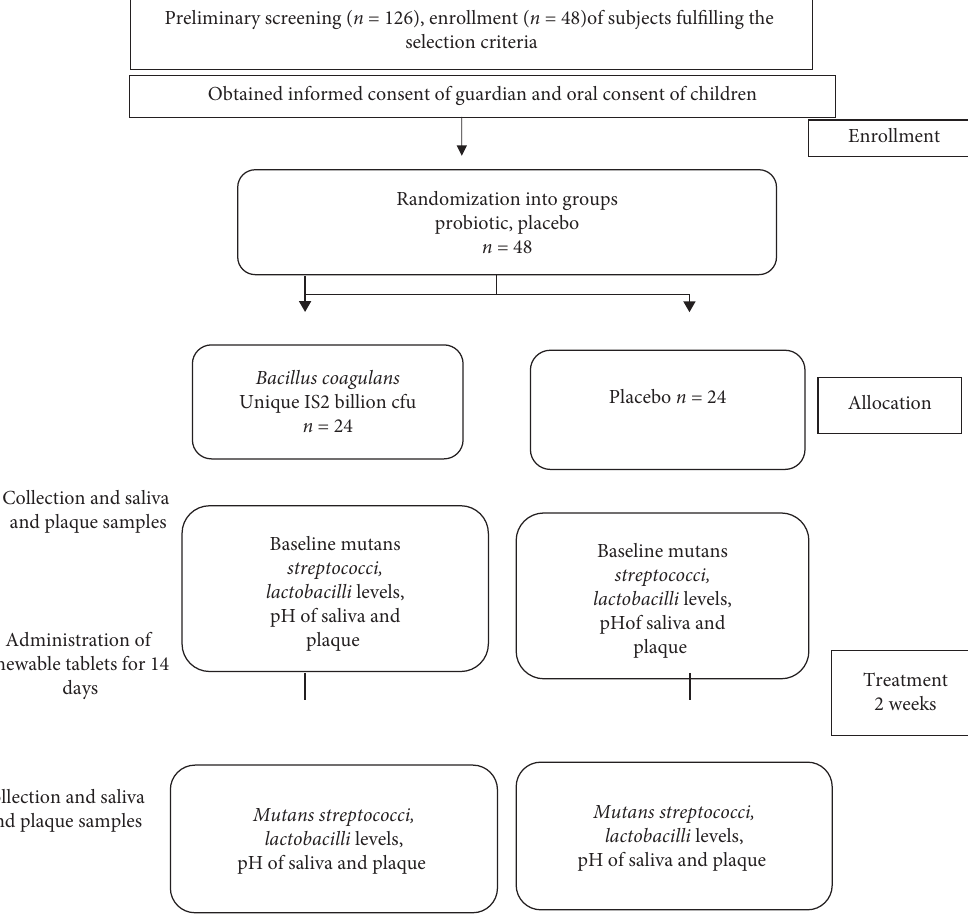
Figure 1: Flow chart of study